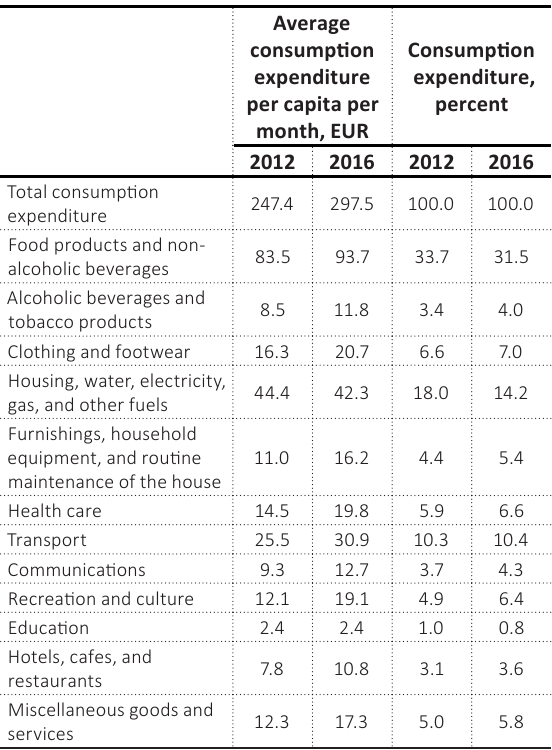
Table 1. Average consumption expenditure